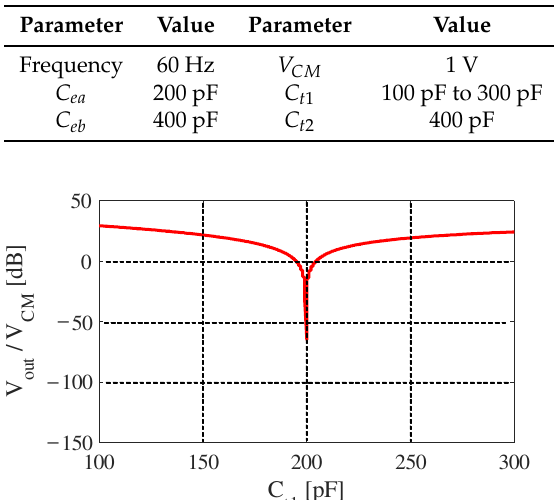
Table 3. The parameters of the simulated circuit components in Figure 3.